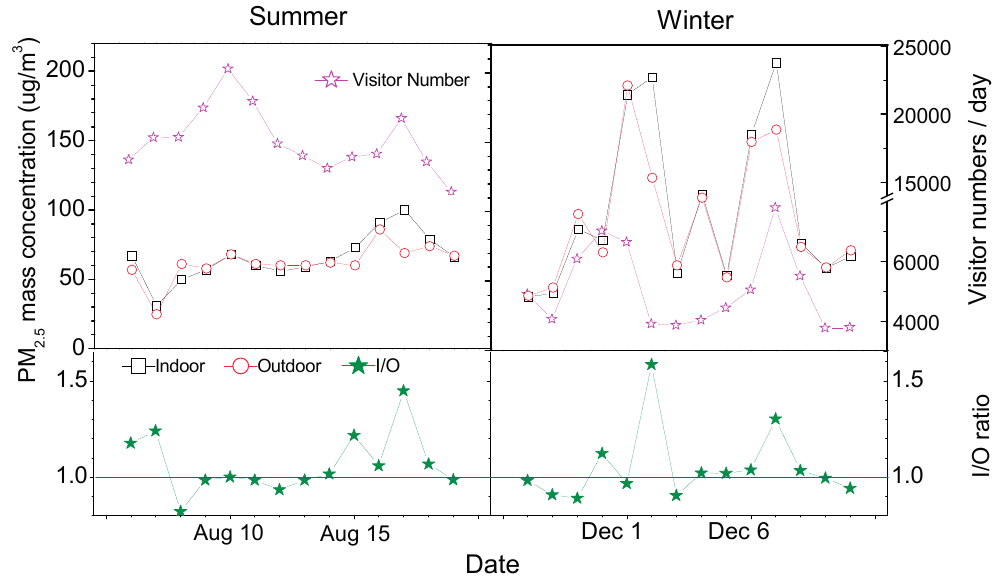
Figure 4. The mass concentrations of PM 2.5 inside and outside the Pit No. 1 display hall, their indoor/outdoor (I/O) ratios and visitor numbers during the summer and winter sampling campaigns in 2013.